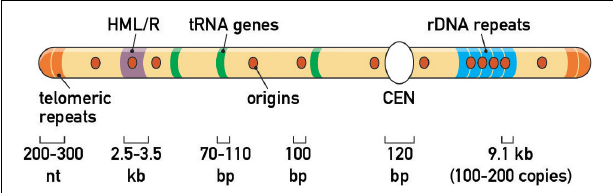
FIGURE 2 | Endogenous fork barriers. Schematic representation of the repertoire of prominent replication fork barriers at a schematic budding yeast chromosome. Note that HML / HMR heterochromatic silencers and rDNA tandem repeats are on different chromosomes in vivo (chr III and XII, respectively). Average size of genomic features is also